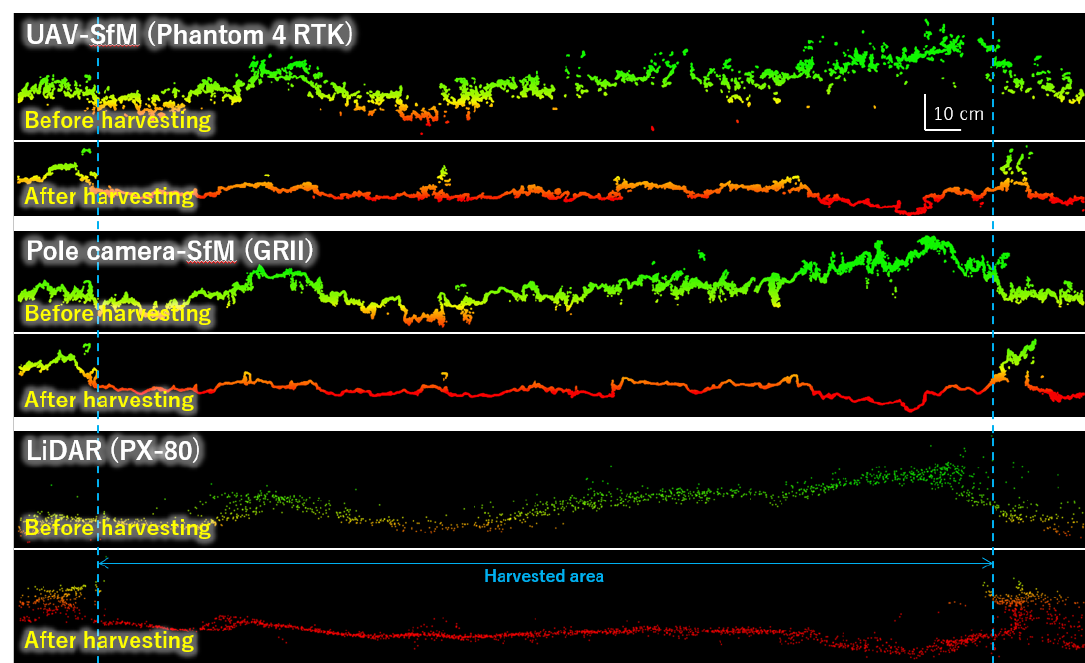
Figure 5. Section views created from the point cloud data. The survey line runs approximately east-west along the center of the measurement range, as shown in Figure 4. Point cloud within a width of 5 mm along the survey line is projected horizontally.